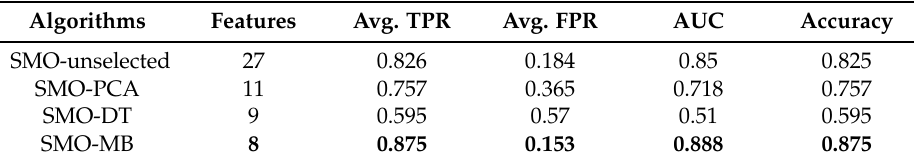
Table 4. Results of different feature selection algorithms using SMO.